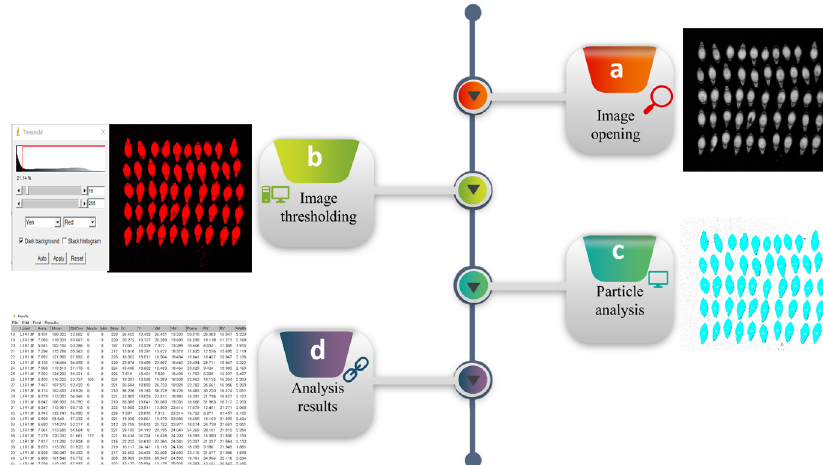
Figure 1. Schematic representation of the processing made by the macro PhenoXray in automated analysis of X-ray images of brachiaria seeds. The main commands implemented by the macro are indicated in the boxes. The input image is open (a) and then segmented (b). After segmentation, particle analysis (c) is performed, in which the results of analysis (d) are generated at the end, with various measurements for each individual seed. For simplification, only one area representative of one of the processed images is